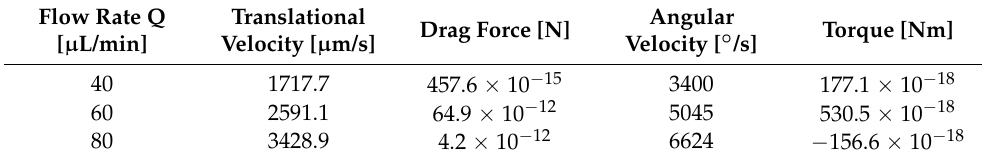
Table 1. Results of FSI simulation of crystal in free